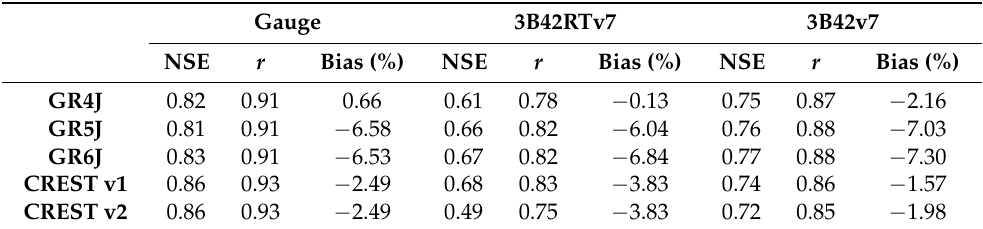
Table 3. Optimal criteria in model calibration.